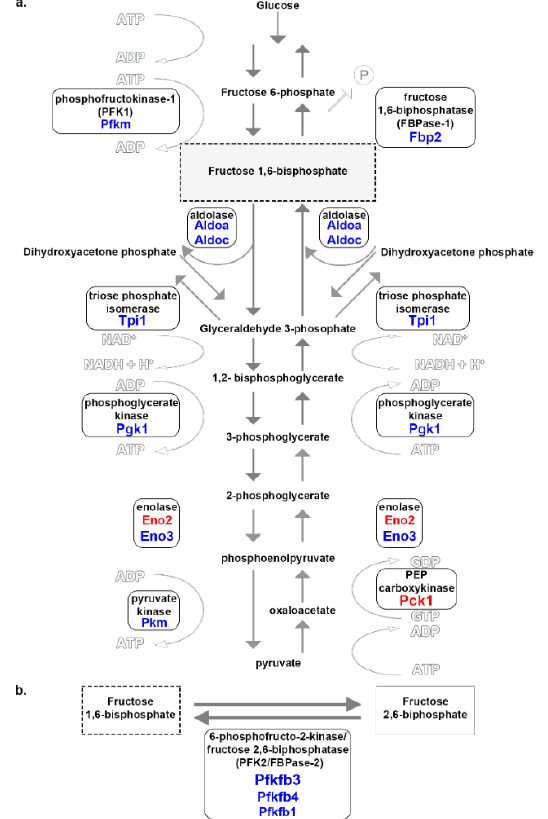
Figure 4. Glucose metabolism associated genes in So and Ta myofibers. Enzymes involved at specific stages are encircled and adjacent to the corresponding reaction arrow. ( a ) Aldoa , Aldoc , Tpi1 , Pgk1 , Eno3 , Pfkm , Pkm , and Fbp2 were increased in Ta. Isoforms of enolase ( Eno2 ) and PEP carboxykinase ( Pck1 ) were increased in So. Represented are guanosine triphosphate (GTP), guanosine diphosphate (GDP), and inorganic phosphate (P). ( b ) Subunits of the PFK2/FBPase2 complex, Pfkfb3 , Pfkfb1 , and Pfkfb4 , were increased in Ta. The red or blue font of gene symbols underneath enzyme names represent increased expression in So or Ta, respectively. Font size correlates to relative FC.